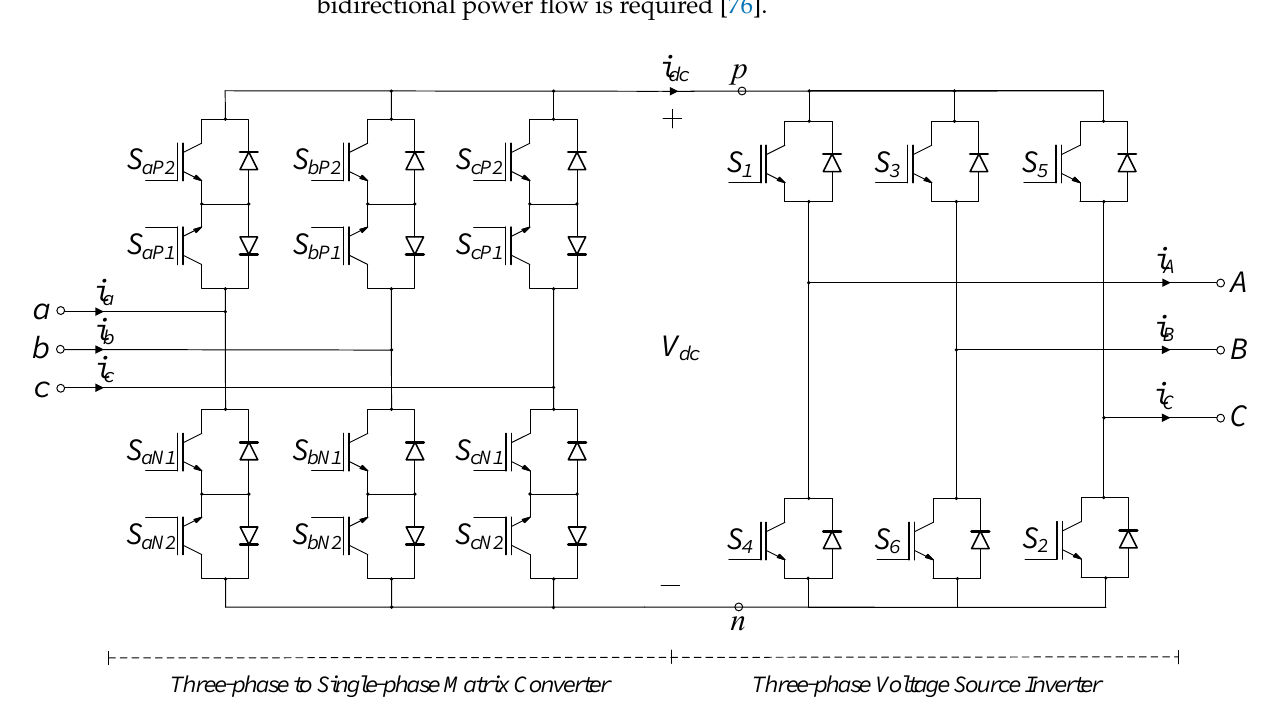
Figure 10. Indirect matrix converter